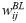
A: single output neuron (green) can learn to pick out a repeating spatio-temporal pattern of firing (red) out of statistically identical noise (black) [5]. In this example the output neuron relies on concurrent input from at least five input neurons in order to fire. Due to instantaneous axonal conduction, the neuron has a very narrow temporal integration window of a few milliseconds (shown in light green). B: If random axonal conduction delays (Δij in our models, see Table 1) are added for the feedforward connections (wijBL in our models, see Table 1), each neuron in the next stage of the model (green) becomes sensitive to a particular pattern of firing in the input. Axonal conduction delays extend temporal integration windows of output neurons (shown in light green). Adding extra output layers with random distributions of axonal delays creates a hierarchy of pattern learning neurons. Neurons at the end of such a hierarchy (blue) have the largest temporal integration windows (shown in light blue) C: different pronunciations of words “one”, “two”, and “three” by two different speakers (red and green dots respectively) lie on different low dimensional manifolds. Polychronous groups (PGs) [6] in the auditory cortex (blue circles) can learn to become sensitive to similar pronunciations of one preferred word (solid ovals). Continuous transformation learning [4] extends the sensitivity of PGs to more different pronunciations of the preferred word (dashed ovals), while maintaining the selectivity of PGs to exemplars of one word only.